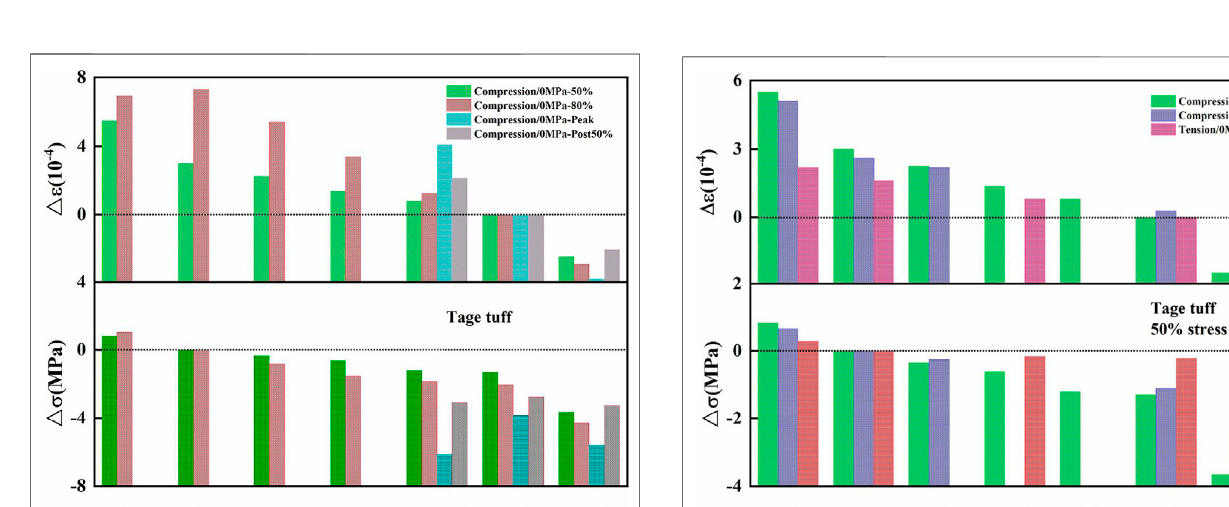
FIGURE 5 | Isochronous curves of Tage tuff at (A) 50%, 80%, peak and post 50% stress levels under uniaxial compression. (B) 30, 50, 70% stress levels under uniaxial tension. (C) 50, 80, 95% stress levels under triaxial compression.